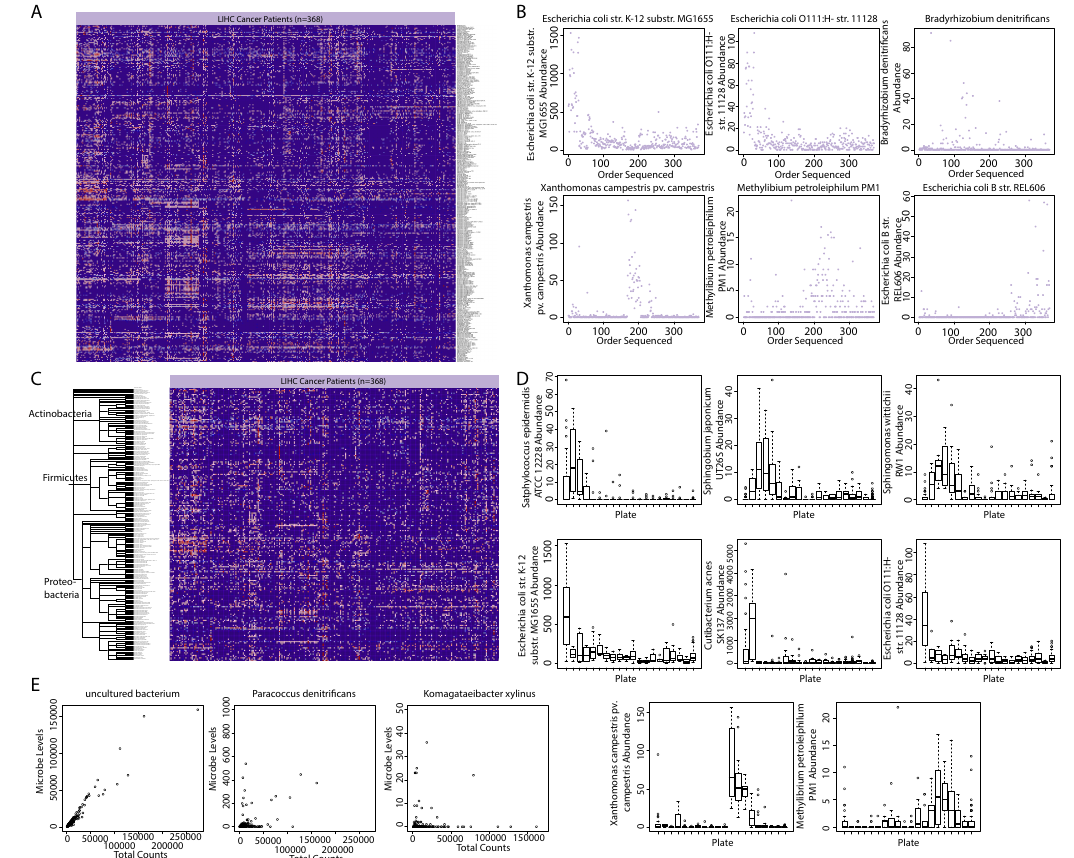
Figure 2. Overview of methods and patient data. ( A ) A heatmap of the original The Cancer Genome Atlas (TCGA) patient data prior to contamination correction. Contamination correction was first performed based on ( B ) sequencing date, with ( C ) potential contaminants removed from the analyses pool. Further correction was done based on ( D ) extreme changes in abundance between sequencing plates and ( E ) deviations in total read counts from a general